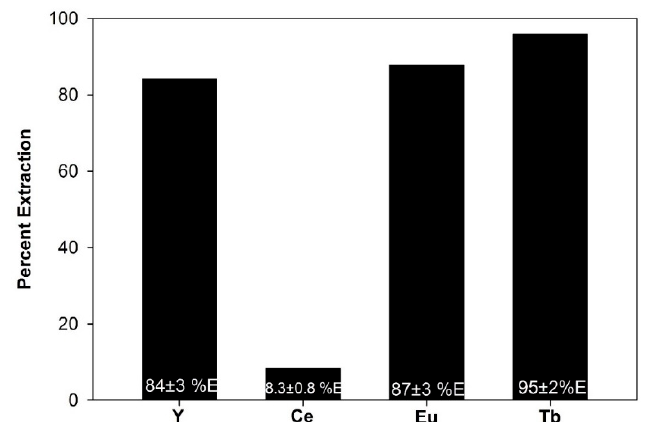
Figure 11. Extraction of 250 mg/kg each Y (III), Ce (IV), Eu (III), and Tb (III) in 8 M HCl with 0.072 M TBDGA in 1 ‐ octanol, 0.5 mol% 1 ‐ octanol, 23 °C, 5 mL/min, 24.1 MPa.